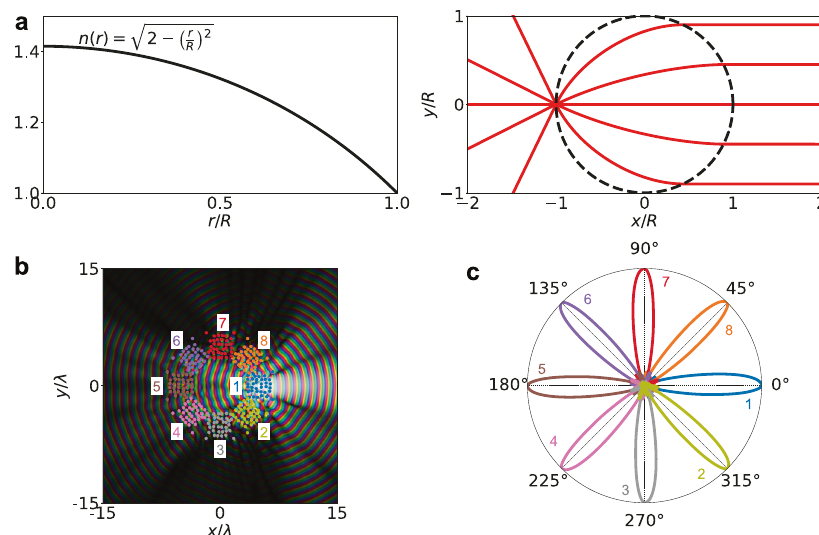
Fig. 5 Multiplexing the design shown in Fig. 4 to construct a Luneburg-like lens. ( a ) demonstrates the function of a normal Luneburg lens of radius R , with a refractive index graded according to the inset equation. A point source is converted into a beam in a single direction. b , c The result of multiplexing the structure proposed in Fig. 4 to produce a Luneburg-like lens with a discrete angular resolution of 45°. By rotating the source and changing its location inside the array the far- fi eld Poynting vectors indicated in ( c ) can be observed. For example, placing the emitter at the centre of array 2 in ( b ), and rotating it by 45° clockwise, results in the far- fi eld directivity labelled as 2 in ( c